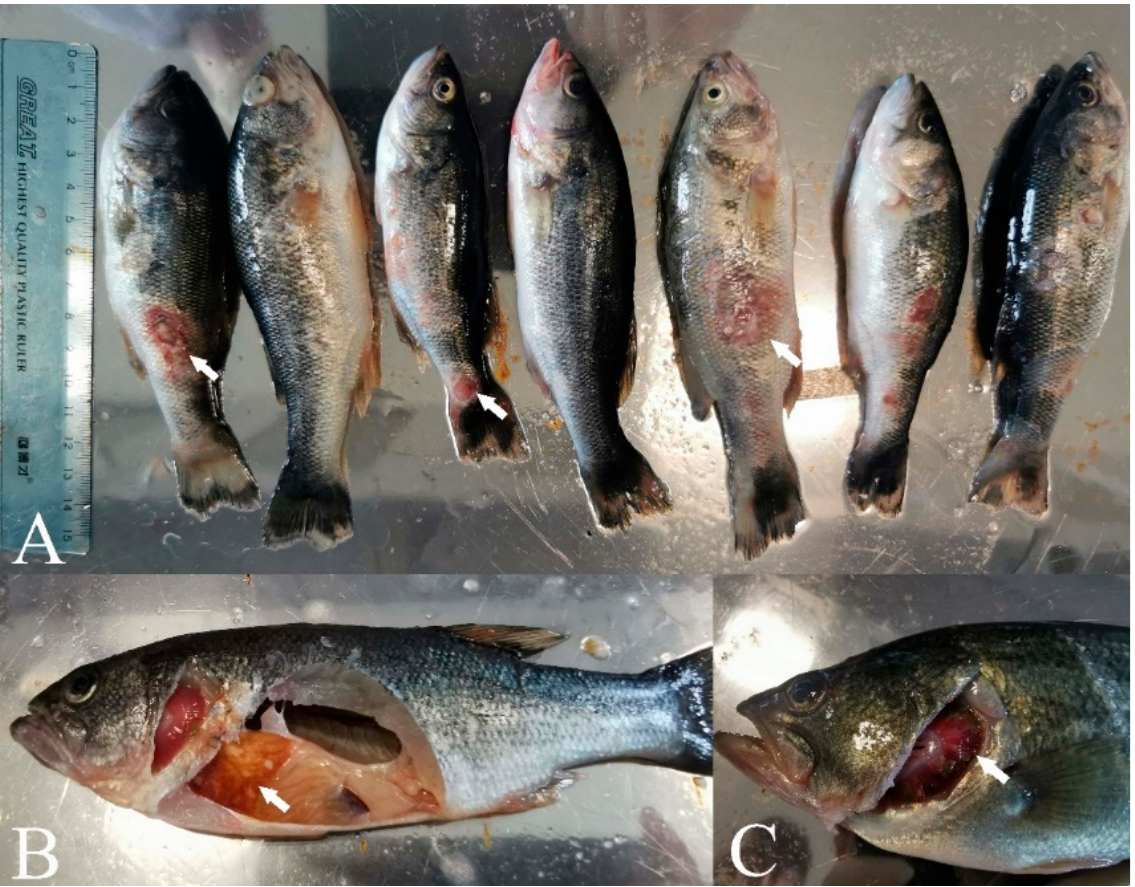
Figure 1. Clinical characteristics of diseased largemouth bass. ( A ) Ulcer lesions on the body surface (white arrows), ( B ) lesions in the viscera (white arrows), and ( C ) bleeding and necrosis lesions on the gills (white arrows).